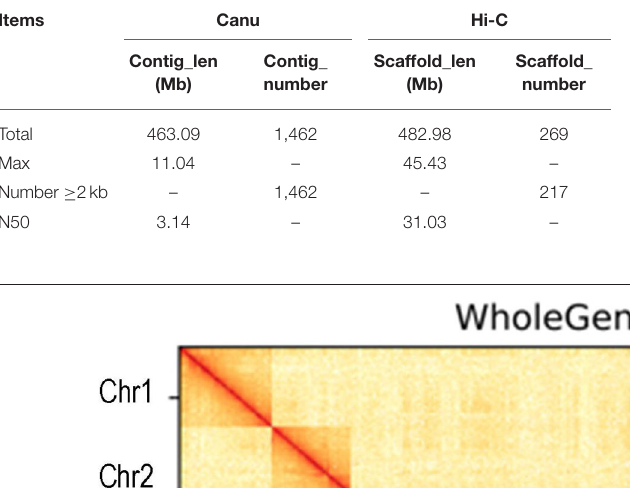
TABLE 1 | Assembly statistics for Capitulum mitella .